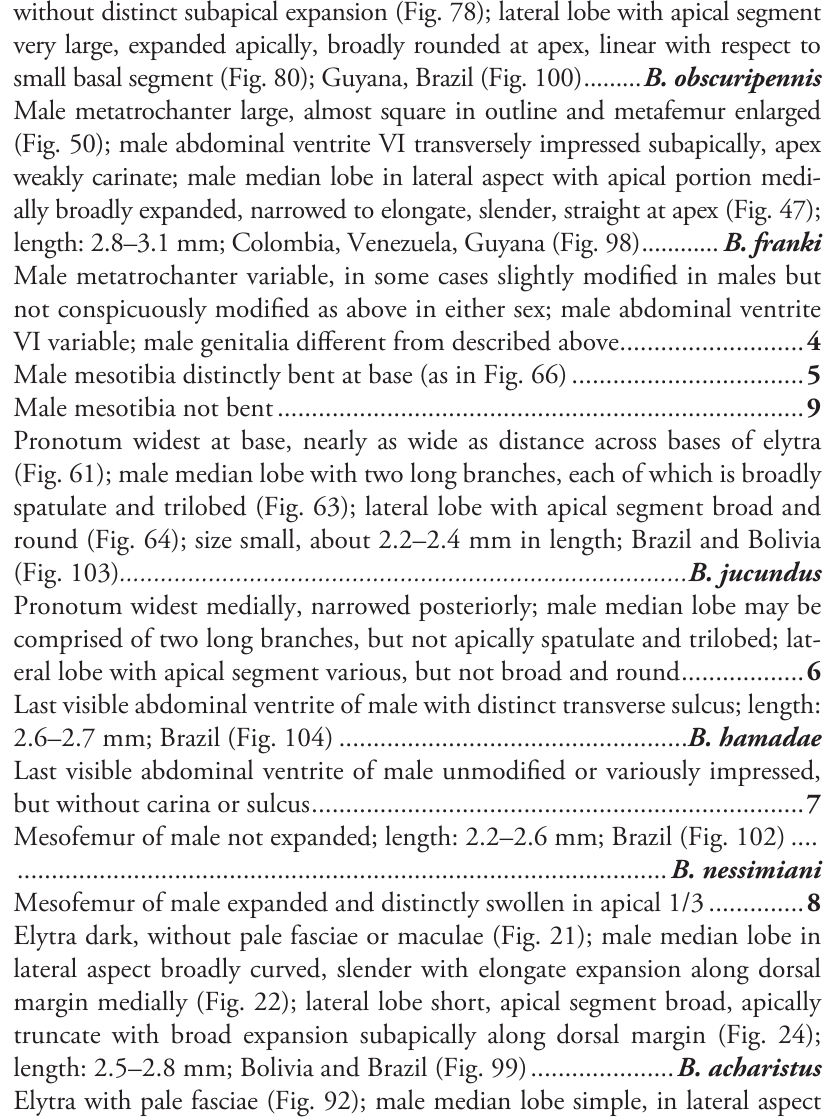
without distinct subapical expansion (Fig. 78); lateral lobe with apical segment very large, expanded apically, broadly rounded at apex, linear with respect to small basal segment (Fig. 80); Guyana, Brazil (Fig. 100) ......... B. obscuripennis 3 Male metatrochanter large, almost square in outline and metafemur enlarged (Fig. 50); male abdominal ventrite VI transversely impressed subapically, apex weakly carinate; male median lobe in lateral aspect with apical portion medi- ally broadly expanded, narrowed to elongate, slender, straight at apex (Fig. 47); length: 2.8–3.1 mm; Colombia, Venezuela, Guyana (Fig. 98) ............ B. franki – Male metatrochanter variable, in some cases slightly modified in males but not conspicuously modified as above in either sex; male abdominal ventrite VI variable; male genitalia different from described above ........................... 4 Male mesotibia distinctly bent at base (as in Fig. 66) .................................. 5 – Male mesotibia not bent ............................................................................. 9 5 Pronotum widest at base, nearly as wide as distance across bases of elytra (Fig. 61); male median lobe with two long branches, each of which is broadly spatulate and trilobed (Fig. 63); lateral lobe with apical segment broad and round (Fig. 64); size small, about 2.2–2.4 mm in length; Brazil and Bolivia (Fig. 103) ................................................................................... B. jucundus – Pronotum widest medially, narrowed posteriorly; male median lobe may be comprised of two long branches, but not apically spatulate and trilobed; lat- eral lobe with apical segment various, but not broad and round .................. 6 6 Last visible abdominal ventrite of male with distinct transverse sulcus; length: 2.6–2.7 mm; Brazil (Fig. 104) ................................................... B. hamadae – Last visible abdominal ventrite of male unmodified or variously impressed, but without carina or sulcus ........................................................................ 7 7 Mesofemur of male not expanded; length: 2.2–2.6 mm; Brazil (Fig. 102) .... ............................................................................................... B. nessimiani – Mesofemur of male expanded and distinctly swollen in apical 1/3 .............. 8 8 Elytra dark, without pale fasciae or maculae (Fig. 21); male median lobe in lateral aspect broadly curved, slender with elongate expansion along dorsal margin medially (Fig. 22); lateral lobe short, apical segment broad, apically truncate with broad expansion subapically along dorsal margin (Fig. 24); length: 2.5–2.8 mm; Bolivia and Brazil (Fig. 99) ..................... B. acharistus – Elytra with pale fasciae (Fig. 92); male median lobe simple, in lateral aspect shallowly curved, expanded medially along ventral margin (Fig. 93); lateral lobe long, apical segment elongate, sinuate and apically slender and sharply pointed (Fig. 95); length: 2.4–2.8 mm; Brazil (Fig. 103) .... B. zimmermanni 9 Abdominal ventrite VI of male deeply impressed on each side, impression medially carinate; pro- and mesotarsomere I of male not laterally expanded, similar to female mesotarsomeres; male median lobe deeply bifid, with each branch with distinctive apical “hooks” in ventral aspect (Fig. 89); size small, length: 2.0 mm (Fig. 87); Brazil and Guyana (Fig. 103) ....... B. subsignatus – Abdominal ventrite VI of male not or only weakly impressed on each side, usually impressed in an oval or round area subapically or otherwise